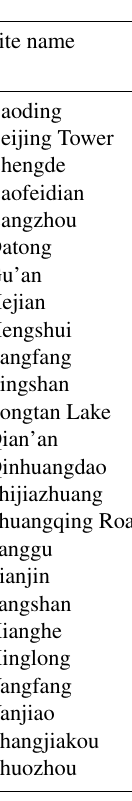
Table 1. Information on air quality observation